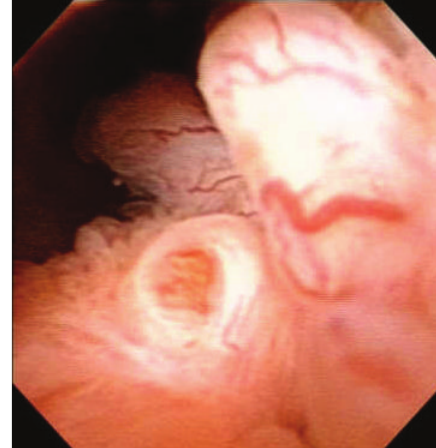
Figure 4: Urethrocystoscopy 3 months after TUR. It revealed that a papillary tumor was there again in the left side, with the prostatic urethra opened. This finding was almost the same as the tumor before